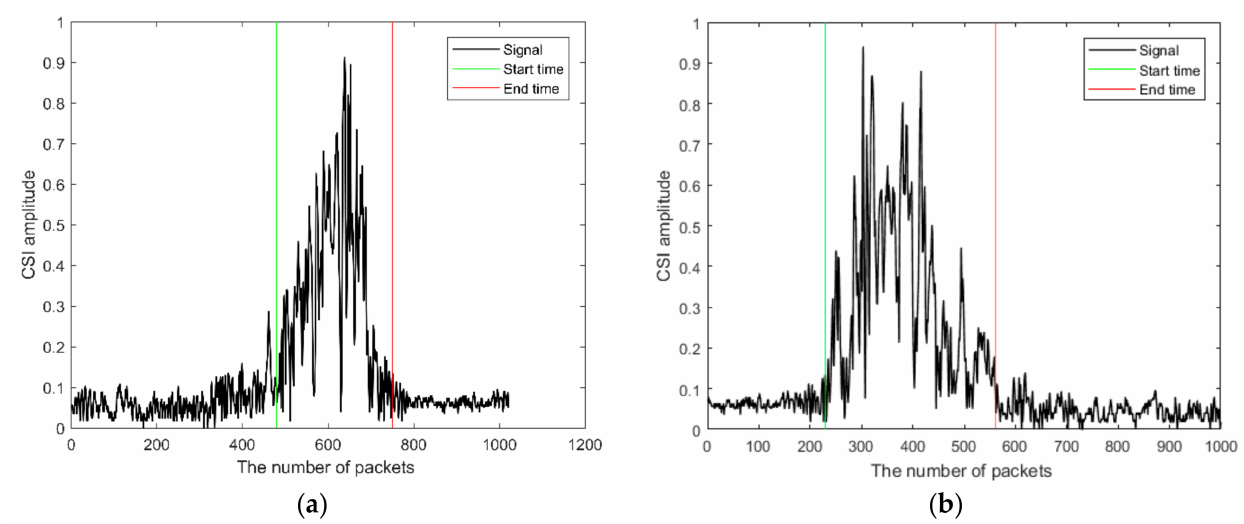
Figure 6. The interval between entering and leaving. ( a ) Leaving the room. ( b ) Entering the